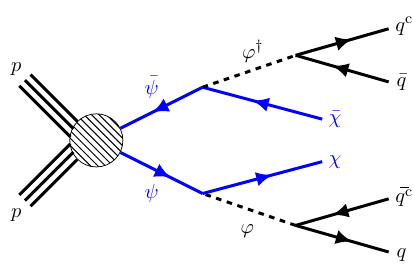
Figure 6 . Pair production of a Z 2 -odd color-sextet fermion (blue) at LHC. Each fermion can decay to the dark matter and (through the sextet scalar) two quarks, generating a jets + E miss provided that m ψ > m χ + 2 m q I